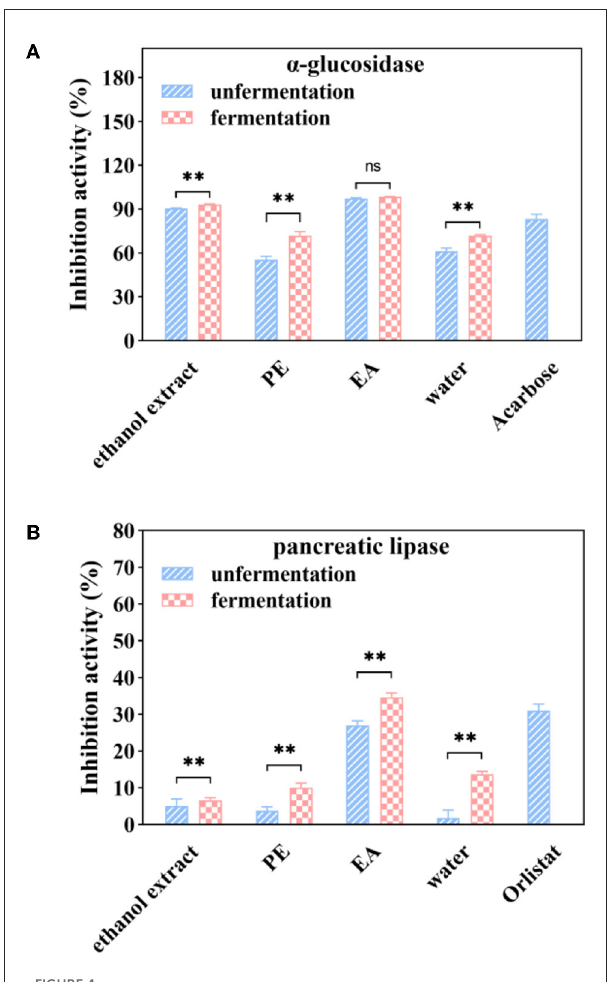
FIGURE4 α -glucosidase (A) and pancreatic lipase (B) inhibition activities of soluble phenolic extracts at different subfractions from AVL fermented with A. niger (100 µ g/ml of acarbose and 1 mg/ml of orlistat as positive controls). ** P < 0.05.